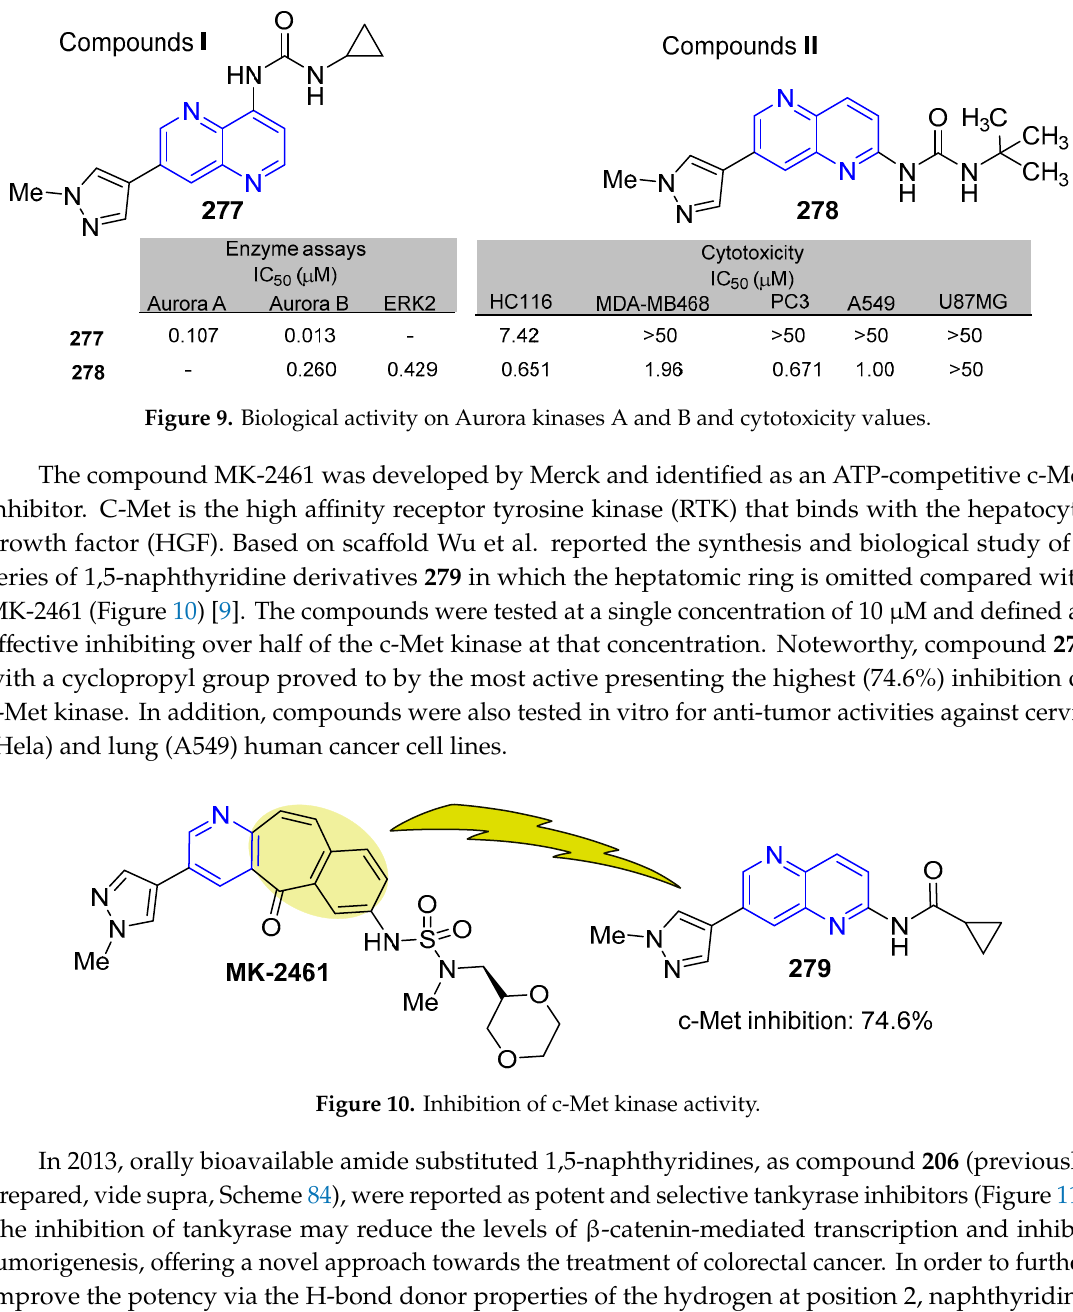
Figure 11. Inhibition of tankyrase activity. DNA topoisomerases unravel turns in DNA that occur as a result of DNA transcription and replication. A series of 4-phenyl-1,5-naphthyridines derivatives exhibited inhibitory effect on topoisomerase I comparable to those observed for the natural inhibitor camptothecin (CPT), and it was the first time that simple 1,5-naphthyridines were tested as topoisomerase I inhibitors [45]. Among the prepared derivatives, aromatized naphthyridines were selected for the evaluation of their therapeutic effect against a human colon cancer cell line (COLO205). The fluorinated derivative 280 (Figure 12) was the most cytotoxic, showing good enzyme inhibition and IC 50 values close to CPT. Figure 12. Inhibition of topoisomerase I activity.